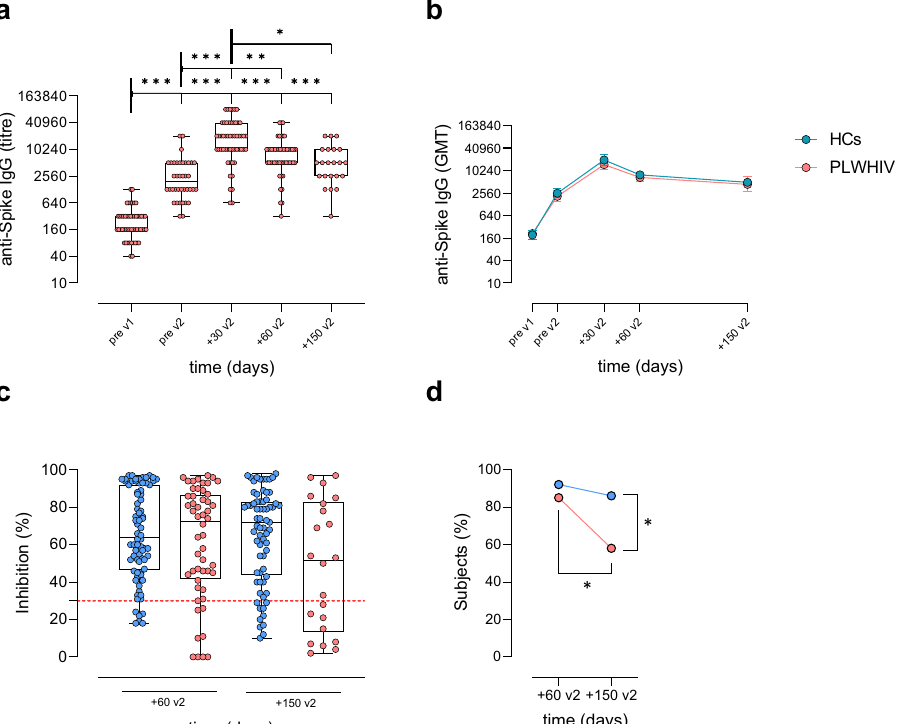
Fig. 2 Spike-speci fi c antibody response following SARS-CoV-2 mRNA vaccination. a Anti-spike IgG detected at pre v1, pre v2, + 30 v2, + 60 v2, and + 150 v2 in plasma of PLWHIV. Data are presented as box and whiskers diagram showing the minimum and maximum of all the data. Kruskal – Wallis test, followed by Dunn ’ s post test for multiple comparisons, was used for assessing statistical differences between groups. * P ≤ 0.05; ** P ≤ 0.01; *** P ≤ 0.001. b Time course of spike-speci fi c IgG response in PLWHIV and HC. Antibody titers are expressed as the reciprocal of the dilution of sample reporting a double OD value compared to the background. Data are presented as geometric mean titers (GMT) with 95% CI. Mann – Whitney test was used for assessing statistical differences between groups at each time point. c , d Surrogate virus neutralization assay (sVN) performed at + 60 v2 and + 150 v2. In c, data are reported as ACE2/RBD binding inhibition percentage with box and whiskers diagram showing the minimum and maximum of all the data. A threshold (dotted red line) was placed at 30% inhibition percentage to discriminate between positive and negative samples. Kruskal – Wallis test, followed by Dunn ’ s post-test for multiple comparisons, was used for assessing statistical differences between groups. The percentage of positive subjects over all samples, tested at each time point, is reported in d. Fisher ’ s Exact Test was used to assessing statistical differences between groups. * P ≤ 0.05; ** P ≤ 0.01. Sample size PLWHIV: pre v1 ( n = 54), pre v2 ( n = 38), + 30 v2 ( n = 53), + 60 v2 ( n = 51), + 150 v2 ( n = 22). Sample size HCs: pre v1 ( n = 25), pre v2 ( n = 50), + 30 v2 ( n = 52), + 60 v2 ( n = 75), + 150 v2 ( n = 69). All samples were biologically